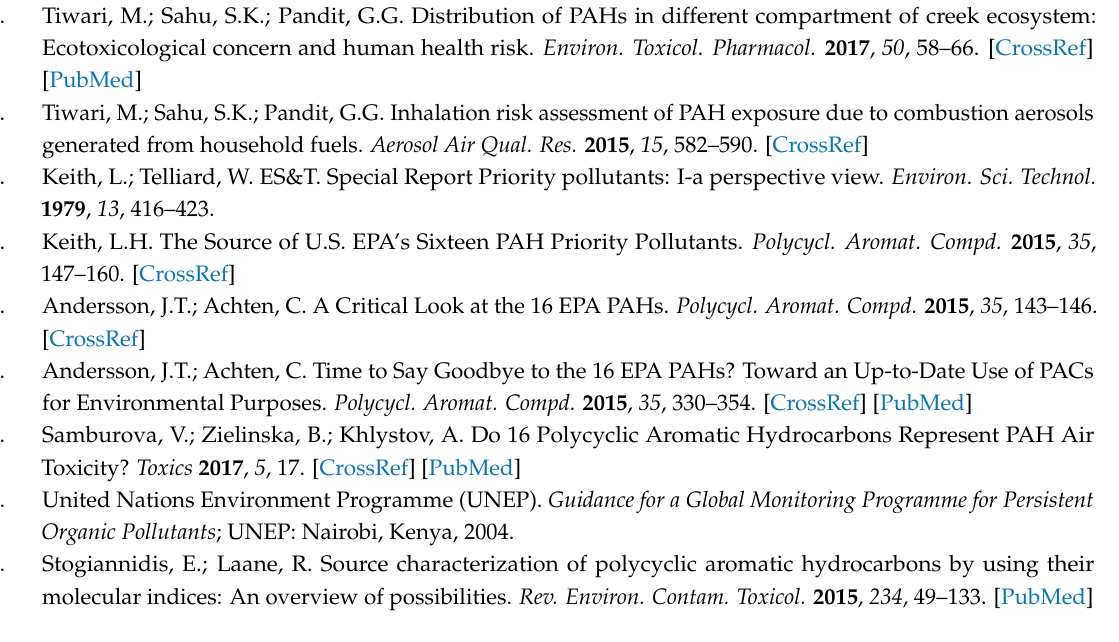
Supplementary Materials: The following are available online, validation of the applied methods and comparison of the structural parameters (bond lengths, angles) of the transition state structures. The relative Gibbs free energy , relative enthalpy, enthropy values and activation Gibbs free energy values computed at the B3LYP/6-31+G(d,p) and M06-2X/6-311++G(d,p) levels of theory and their comparison. The transition state structures along with the interatomic distances and bond angles at the given reaction